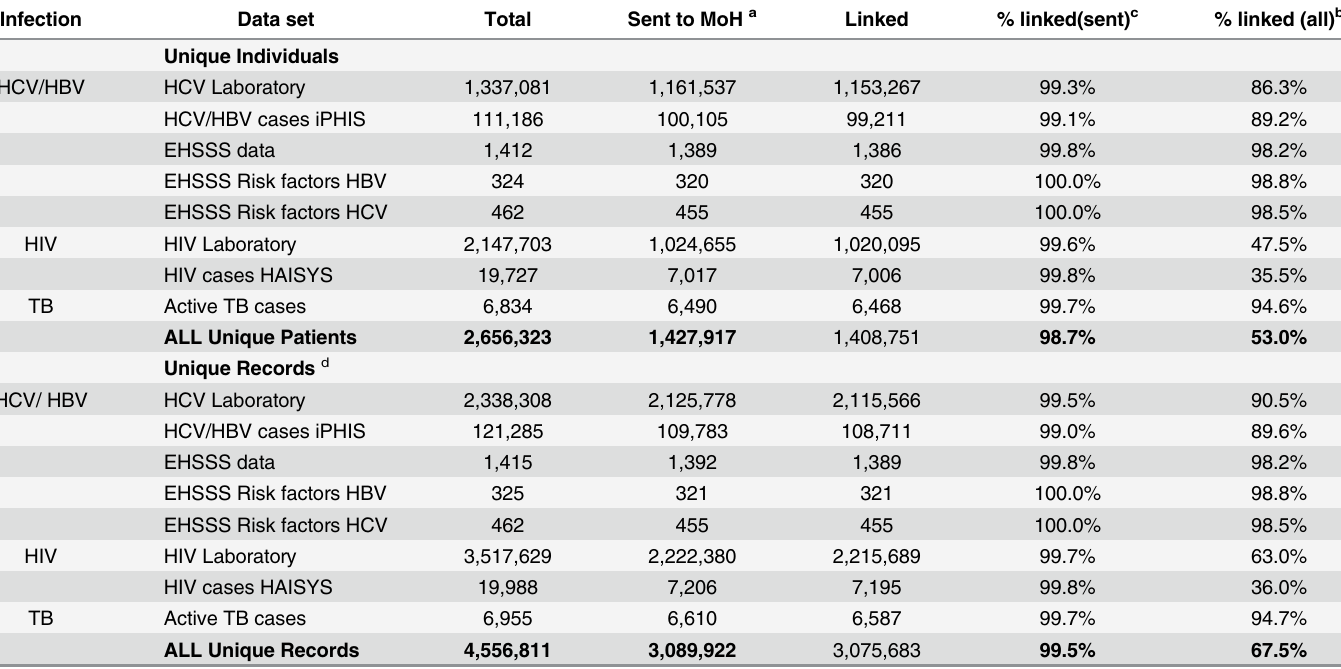
Table 2. Number of total and linked records and unique individuals in various data sources constituting the BC-HTC,